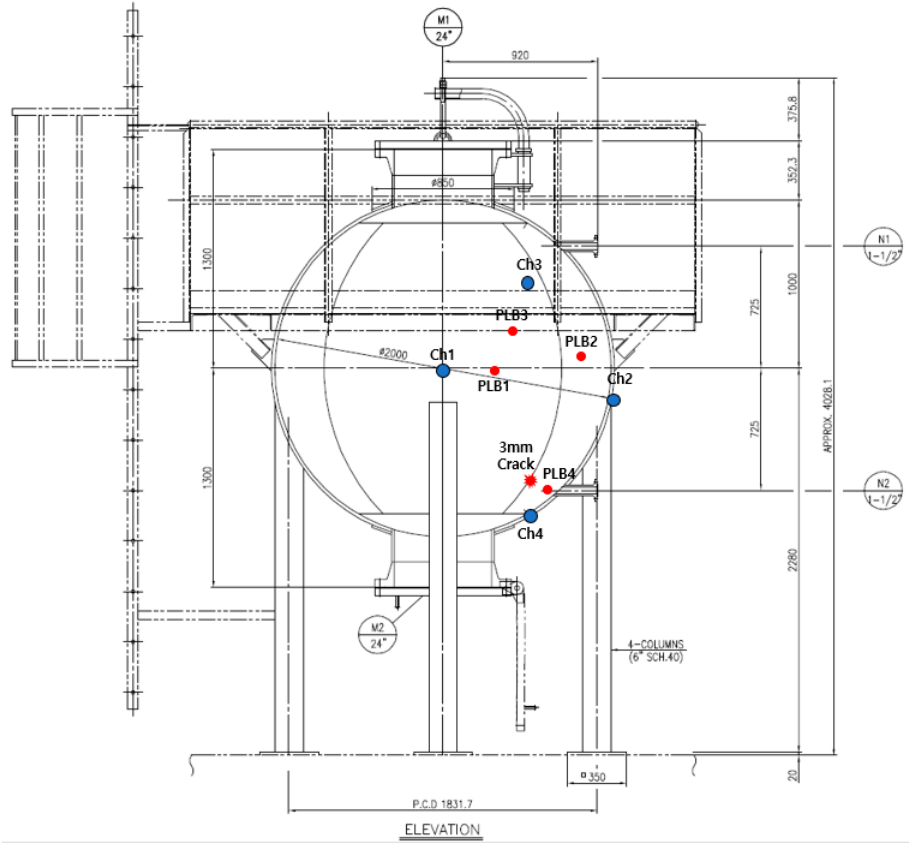
Figure 5. Schematic representation of the testbed.